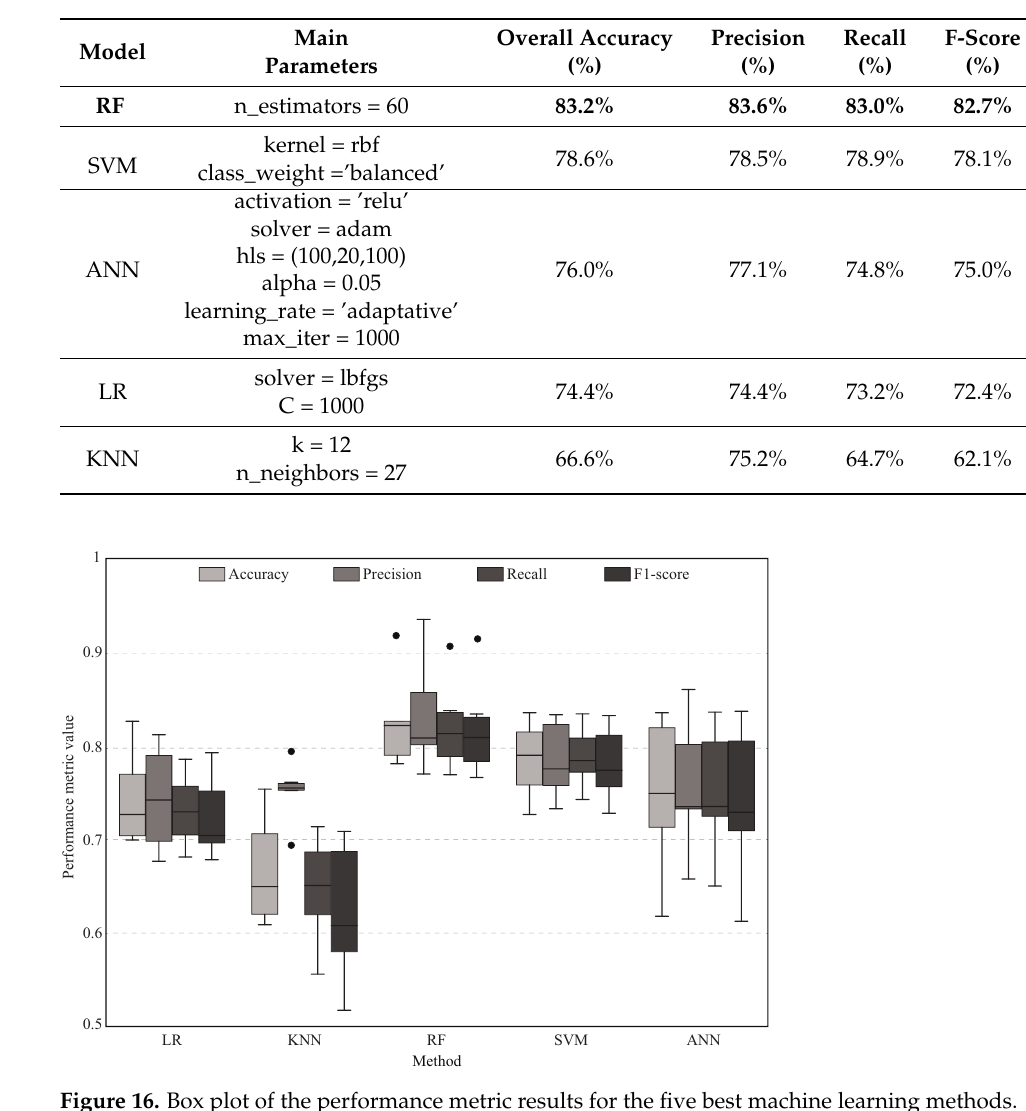
Table 4. Performance of the five best fatigue estimation models. Bold values show the best score for each performance metric.